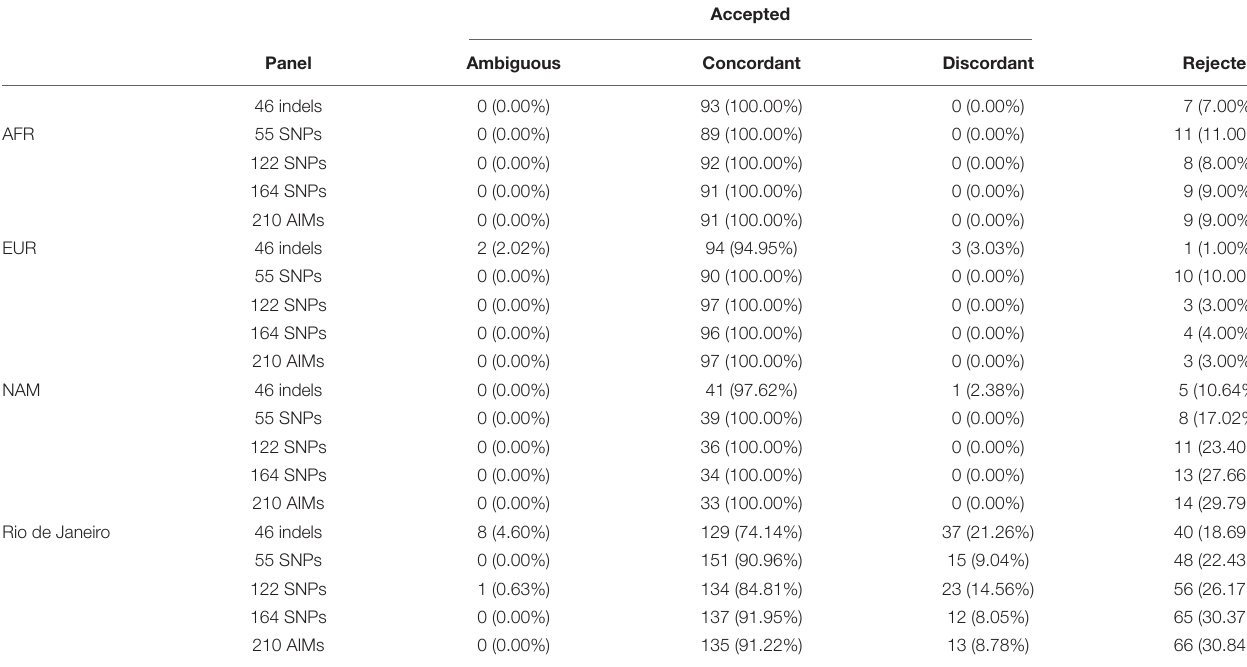
TABLE 1 | Results of BGA inferences for five AIM panels, considering AFR, EUR, NAM, and Rio de Janeiro